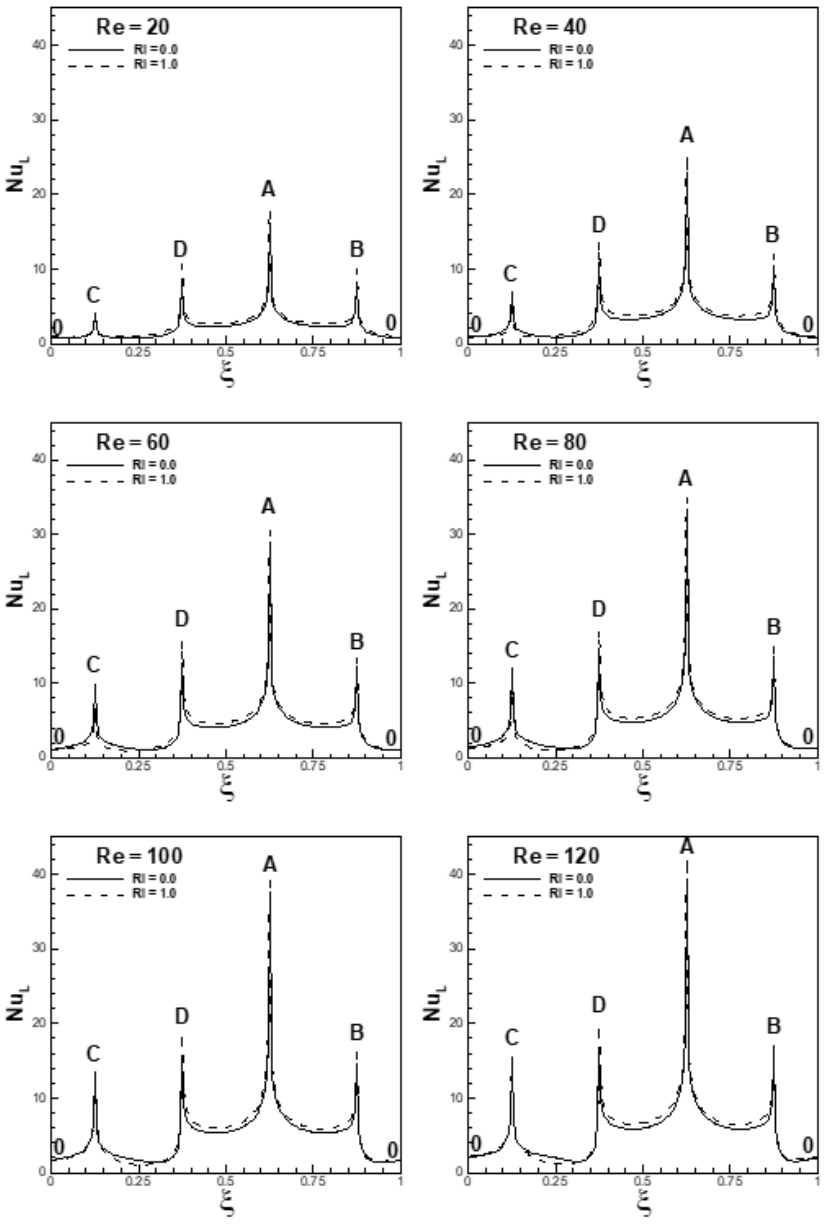
Figure 33. Variation of local Nusselt number along the surface of the cylinder at α = 45 ° , 20 ≤ Re ≤ 120 and Ri = 0 and 1.0.